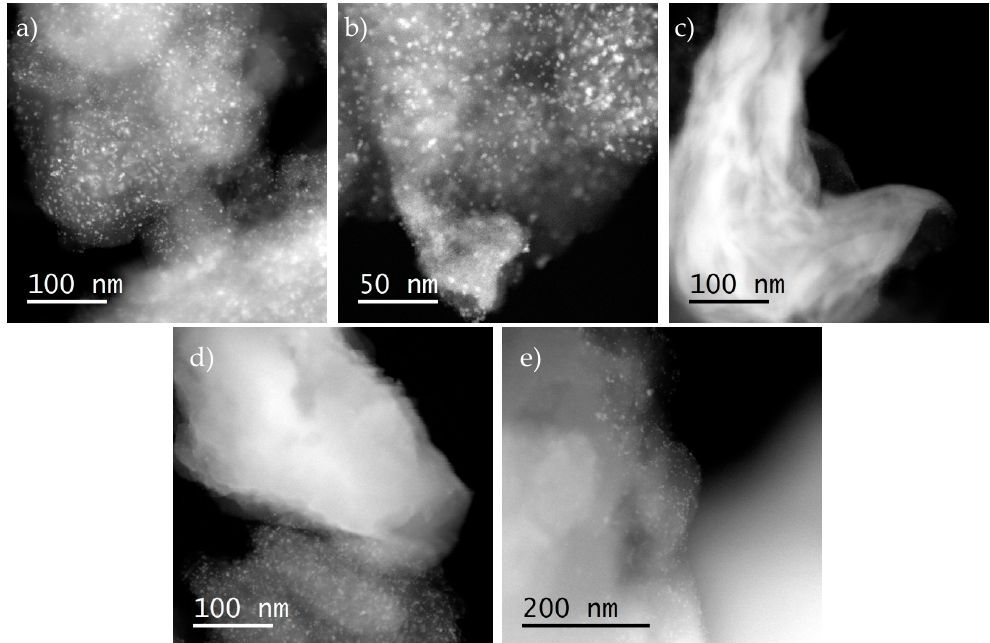
Figure 4. STEM-high angle annular dark field (HAADF) micrographs of catalysts exposed to UV-vis irradiation for 6 h in the presence of lactic acid. ( a ) Pt/CN, ( b ) Pt/2H MS-CN (PD), ( c ) Pt/2H MS-CN (SC), ( d ) Pt/1T MS-CN (SC), ( e ) Pt/2H MS-CN (TD).